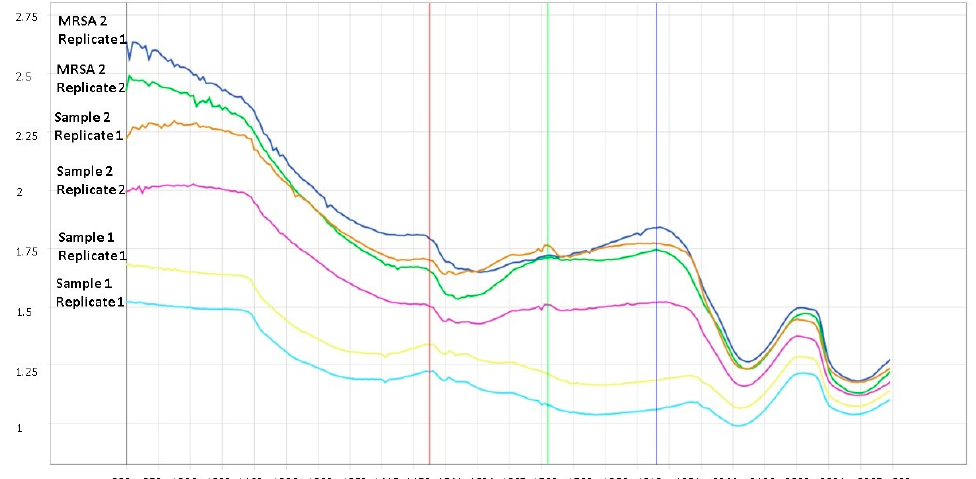
Figure 2. Average spectrum of HSI of MRSA samples and test samples. Blue color refers to MRSA 2/replicate 1; green color refers to MRSA 2/replicate 2.